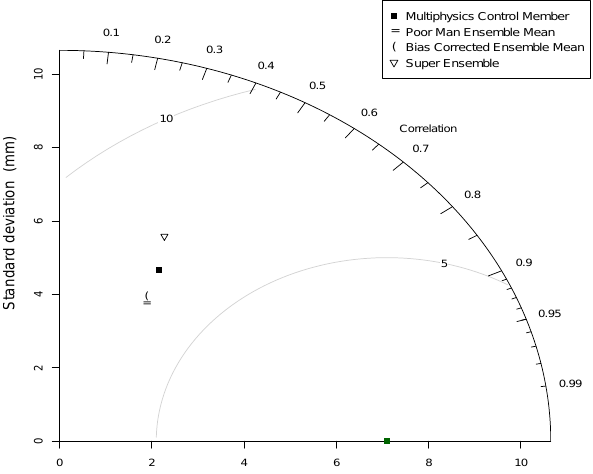
Fig. 8. Taylor diagram for the multiphysics ensemble control member, the multiphysics ensemble mean, the bias corrected ensemble mean and the superensemble, as functions of different rainfall event thresholds. Note: training period 19 MEDEX cases and forecast period September–December